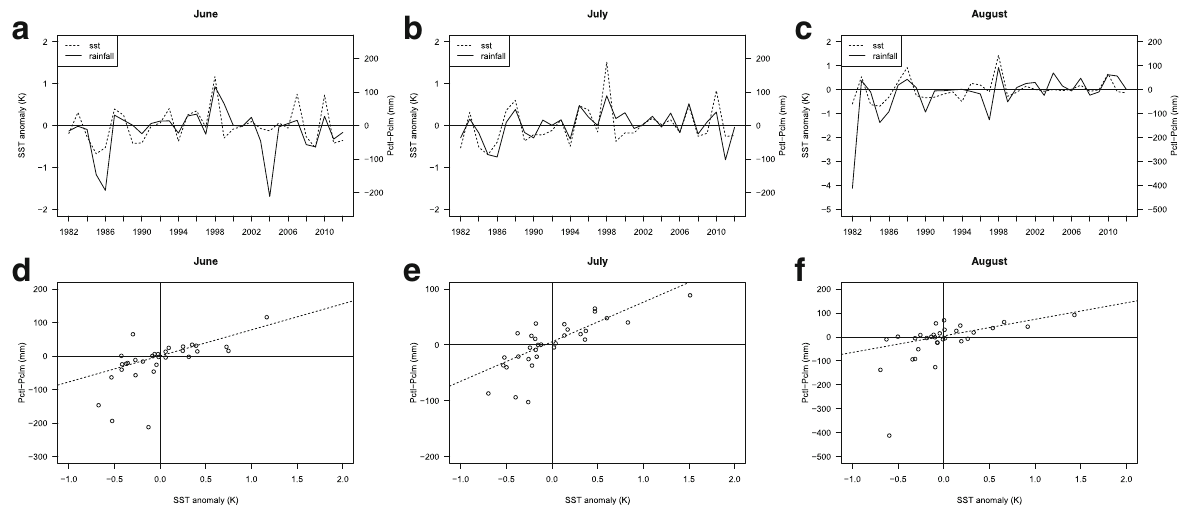
Fig. 6 Time series ( a – c ) and scatter plots ( d – f ) of the area-averaged monthly mean SST anomalies in the WSST region and monthly precipitation difference ( P CTL − P CLM ) in the WPH region for June, July, and August, respectively. The dashed line in the scatter plot indicates the linear relationship between SST anomaly and rainfall sensitivity estimated using the Theil – Sen method